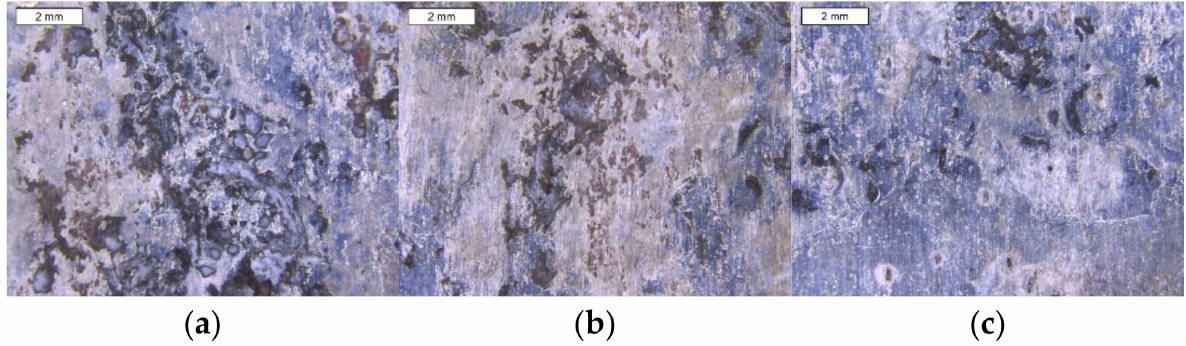
Figure 12. Stereoscopic image of the surface of the samples after the NSS test: T6 state ( a ), DA ( b ), and RRA ( c ).